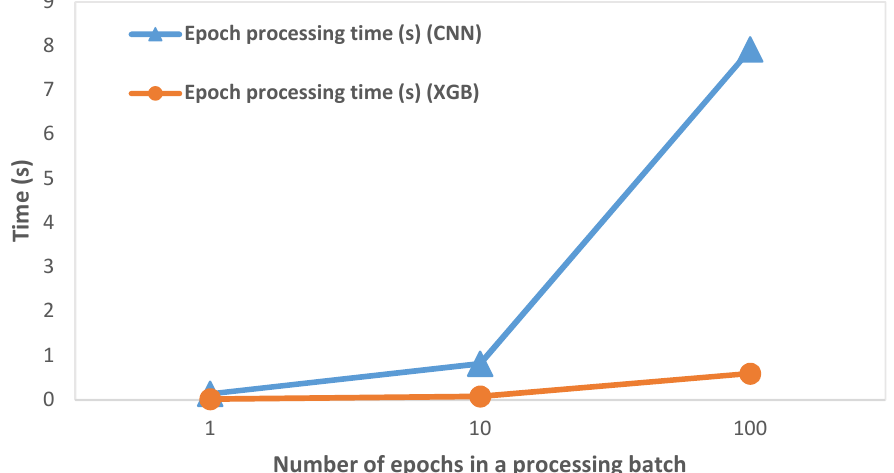
Figure 4. Variation of epoch processing time with the number of epochs on RPi (64 s epoch).